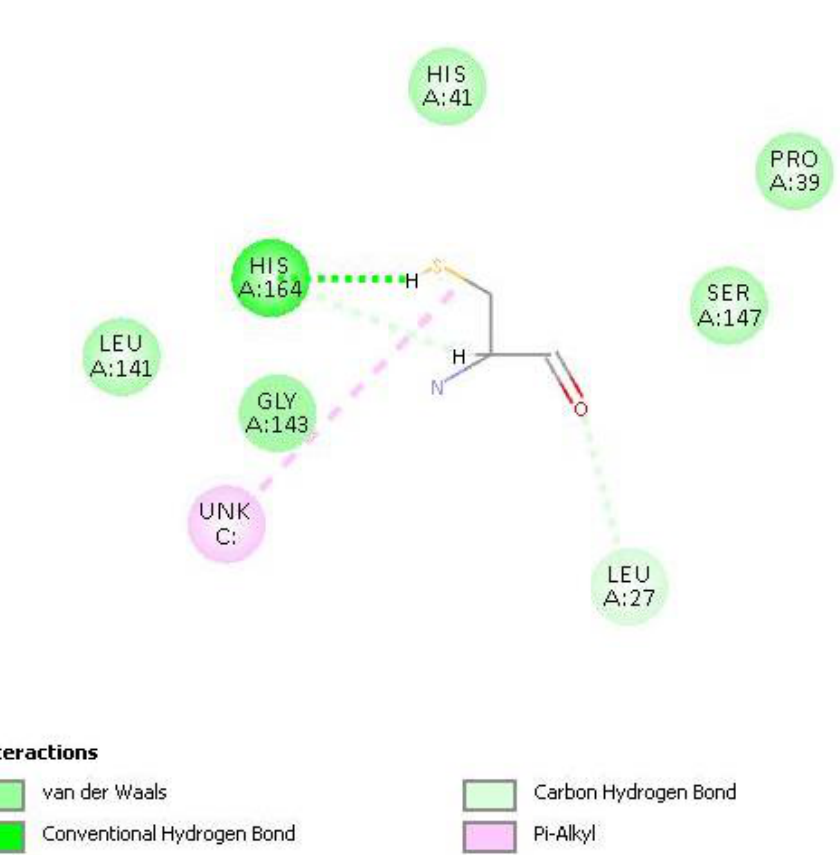
Figure 17. 2D interactions after dynamic cascade of Cys145 shows H-bond to O(His164), suggesting SH cleavage.